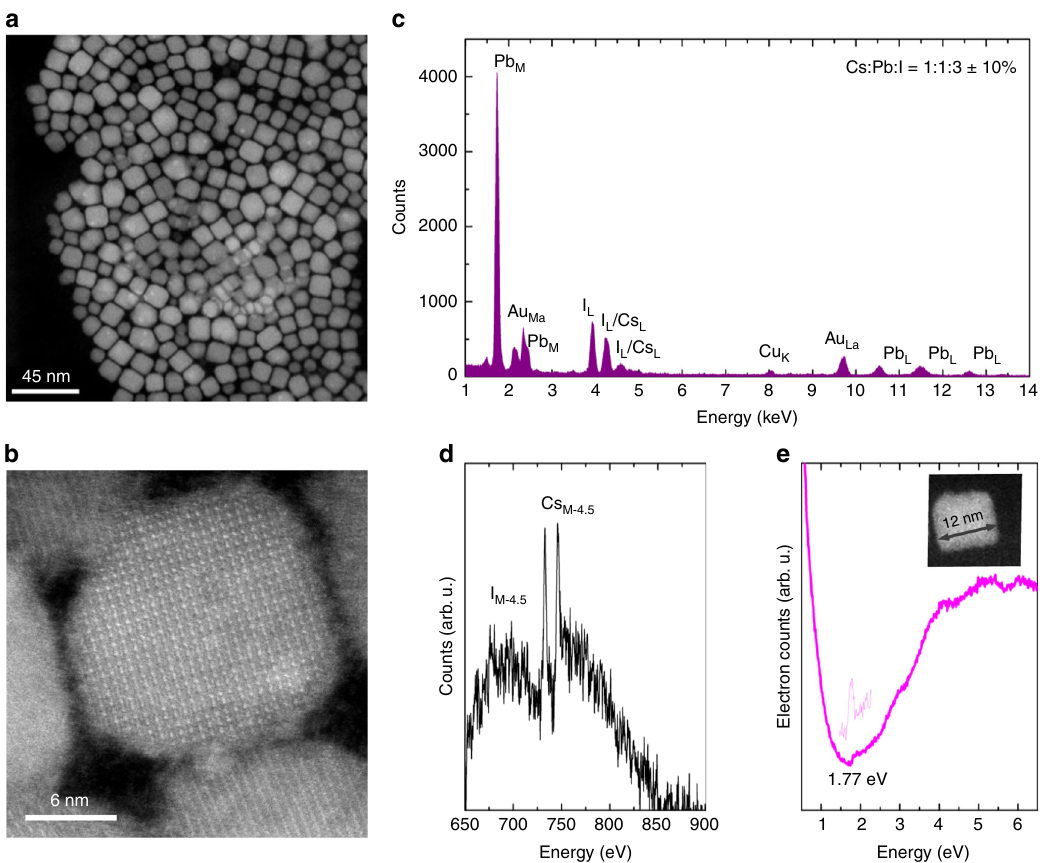
Fig. 1 Microscopic characterization of the CsPbI 3 nanocrystals. a Annular dark fi eld image of the freshly drop casted sample. b Atomic resolution scanning transmission microscopy image of a nanocrystal showing clearly their mostly cubic structure. c , d Energy dispersive X-ray spectrum of the same sample ( c ) and the core-loss electron energy loss spectrum ( d ) where mainly Cs, Pb and I are detected. The Cs:Pb:I ratio is 1:1:3 ± 10%, as determined from the quanti fi cation of the energy dispersive X-ray signal for the L-lines of the corresponding elements, which suggests (mostly) the perovskite composition. e Low-loss electron energy loss spectrum of a large, 12 nm nanocrystal, with a band gap energy of 1.77 eV. The dotted line indicates the fi rst derivative of the spectrum around the absorption onset, where its maximum is taken as the NC band gap